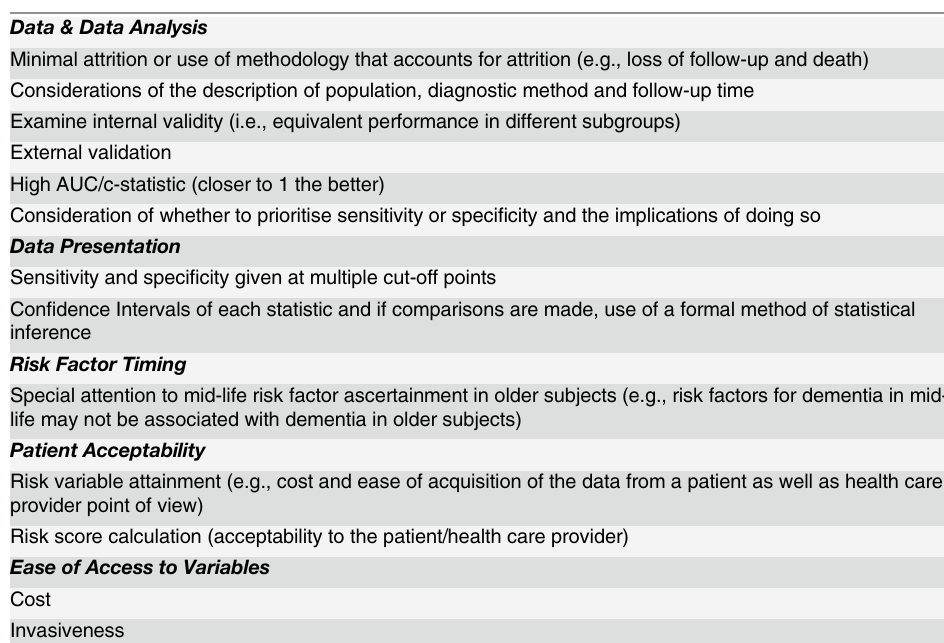
Table 4. Optimum features of study design and variables selected for dementia risk prediction